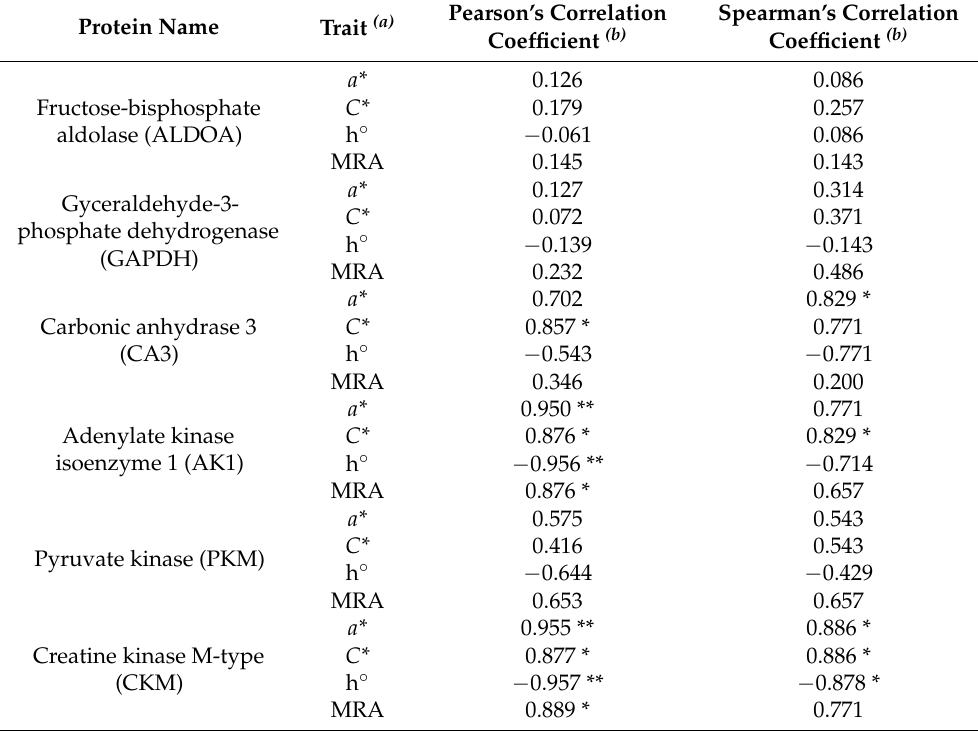
Table 3. Correlation coefficients (Pearson and Spearman) of differentially abundant proteins in ovine M. longissimus lumborum (LL) with color attributes ( n =